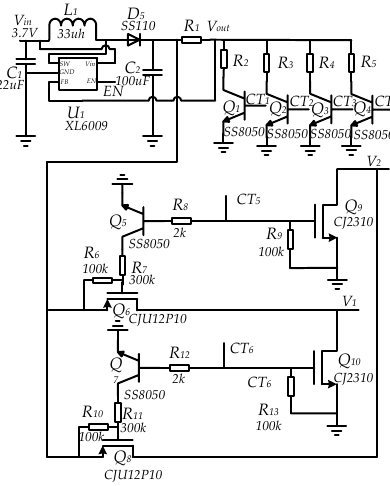
Figure 2. Circuit diagram of the electroporation for high-voltage electric pulse.